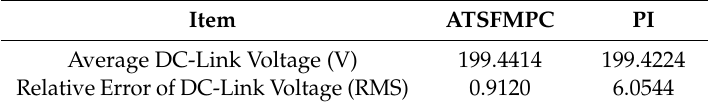
Table 3. Comparison of DC-link voltage regulation performances for Pentland Firth tidal